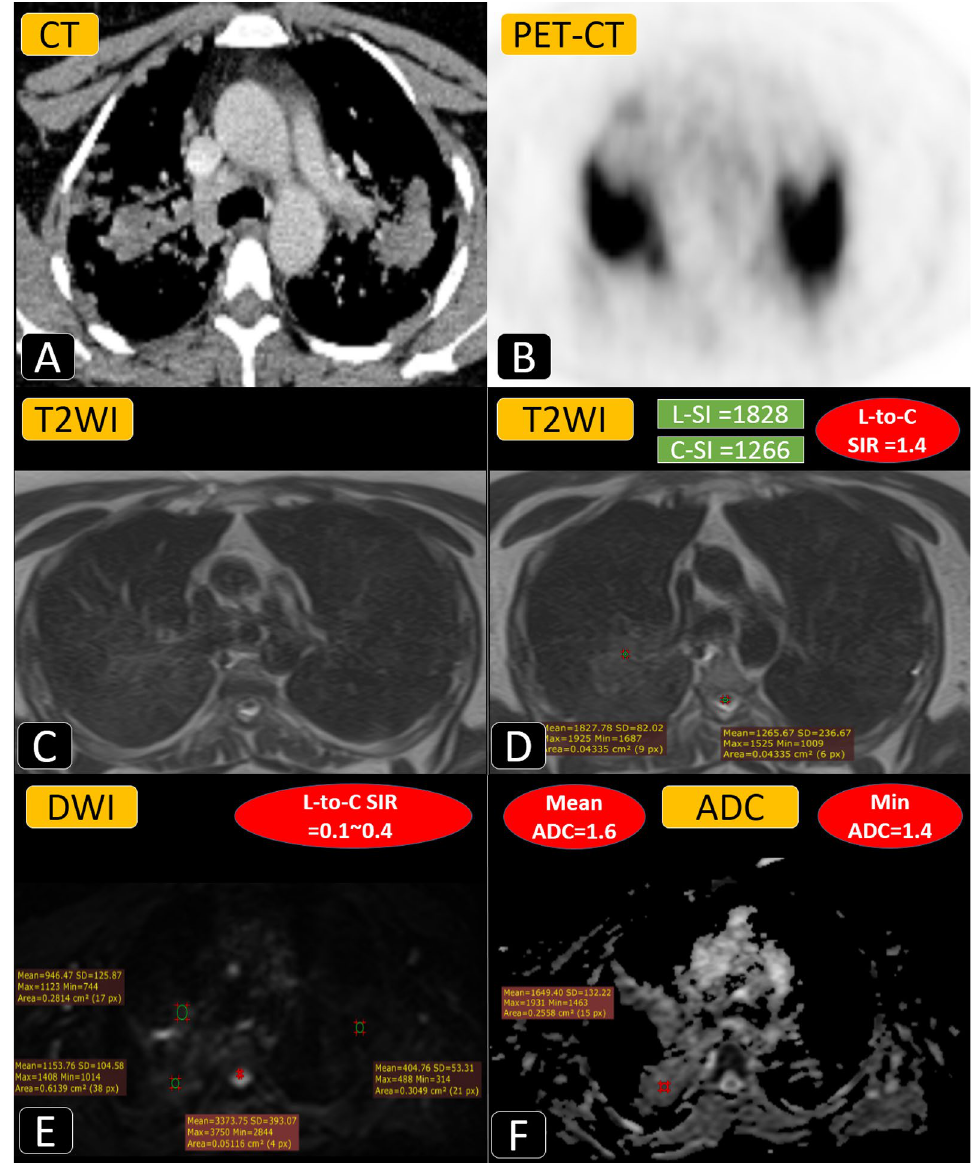
Fig. 9 A 25-year-old male patient complained of chronic cough and dyspnea. A Axial contrast-enhanced chest CT cut (mediastinal window) showed bilateral upper lobar peri-hilar lung masses and scattered peripheral lung nodules. B Axial chest PET-CT image showing high bilateral 18F-FDG uptake. C , D Axial T2WI shows the low signal intensity of the lesion. After placing two ROIs within the largest lesion and the spinal cord, the lesion-to-spinal cord signal intensity ratio was calculated 1.4. E Axial DWI showing low signal intensity denoting non-restricted diffusion = and lesion-to-spinal cord signal intensity ratio was calculated 0.1–0.4. F ADC mapping images showing low signal intensity with minimum = ADC (1.4 10 − 3 mm 2 /s) and mean ADC (1.6 10 − 3 mm 2 /s). Referring to the estimated cutoff values, only the T2WI L-to-SC SI ratio concerned × × malignant nature; meanwhile, the DWI L-to-SC SI ratio, minimum ADC, and mean ADC suggested a benign process. Pathologically proven fibrosing parenchymal sarcoidosis. (Example for truly positive DWI parameters and false positive T2WI ratio and